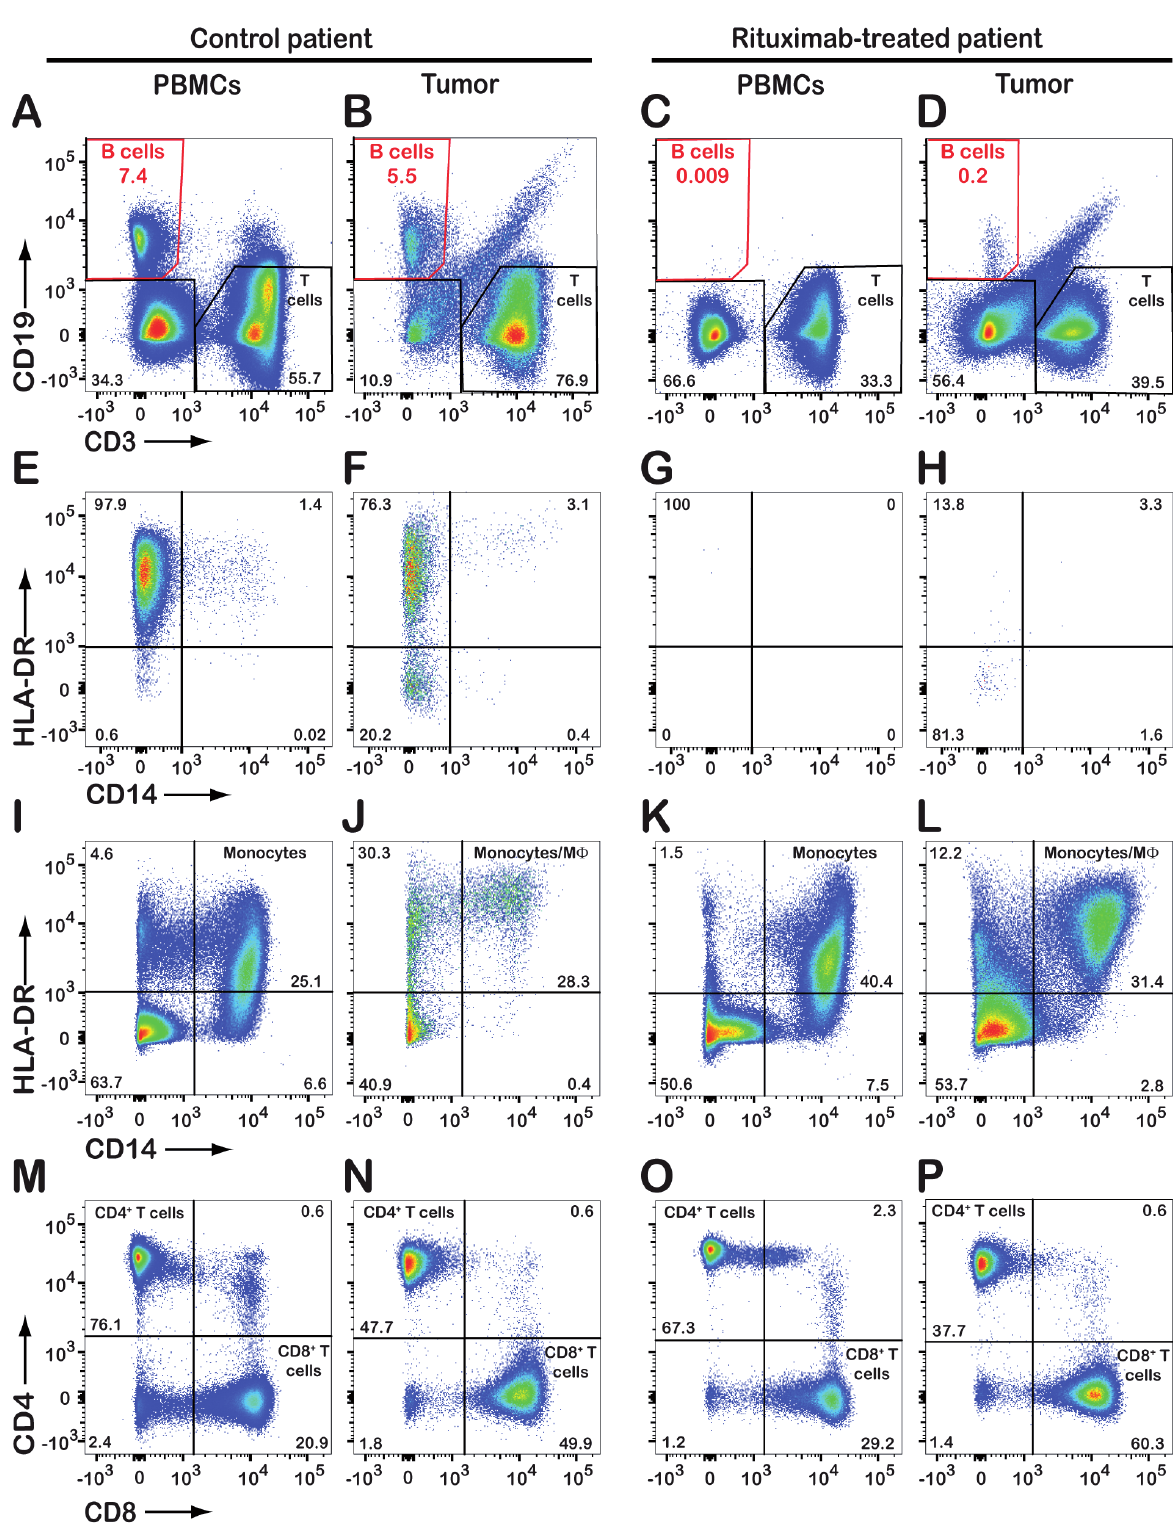
Figure 1. Flow cytometric analysis reveals the absence of tumor-infiltrating CD19 + B cells in a patient treated with rituximab. Upon chest surgery for removal of a lung tumor from a patient previously treated with rituximab, tumor biopsy and serum samples were analyzed by flow cytometry. Results from a control lung cancer patient (not treated with rituximab) are shown for comparison. Both patients were diagnosed with lung adenocarcinoma. CD45-positive leukocytes were gated and analyzed further for expression of CD19/CD3 ( A – D ), HLA- DR/CD14 ( E – L ), and CD4/CD8 ( M – P ). The dot plots E – H show expression of HLA-DR and CD14 by CD19-positive B cells only (red gates in A – D ). Numbers in quadrants indicate the percentage of cells detected. PBMCs, peripheral blood mononuclear